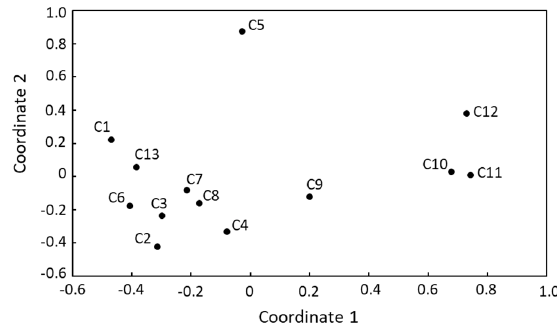
Figure 5. nMDS plot of terminal restriction fragments length polymorphism (T-RFLP) patterns from the different compost samples (C1–13) based on Bray–Curtis similarities in 16S rRNA gene fragments digested with Alu I , Hha I and Rsa I.